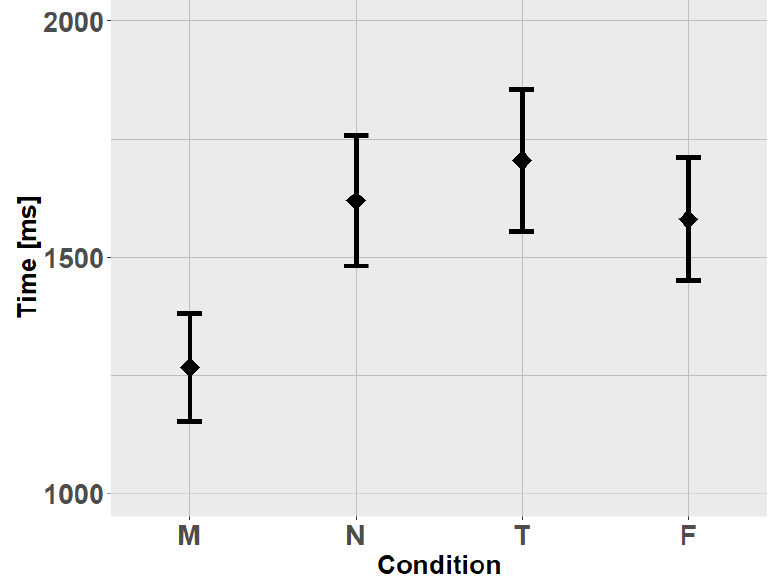
Figure 3. Time of successive selection of the balls in different conditions (N = 23, M ± 95% CI). For the description of conditions, see the caption of Figure 1.